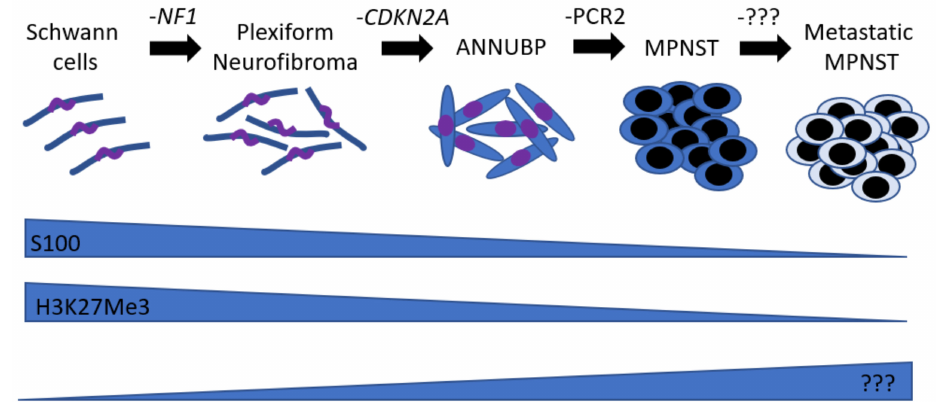
Figure 1. Neurofibroma to MPNST sequence. Schematic illustrating the genetic events driving the neurofibroma to MPNST sequence and the relative expression of markers associated with this